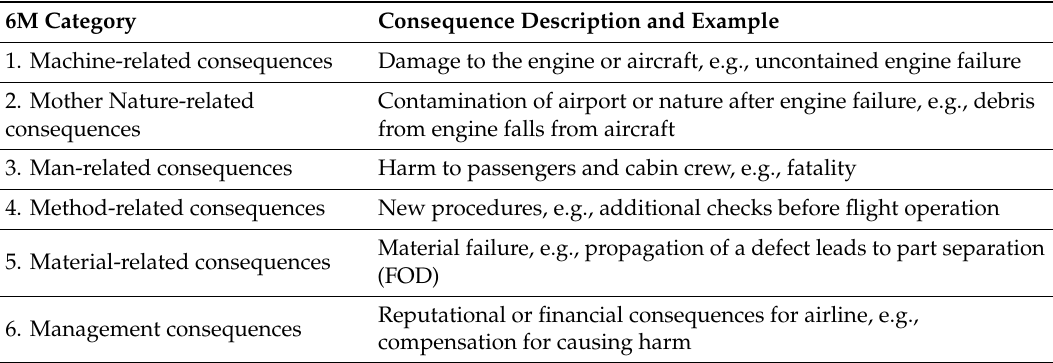
Table 4. The 6M categories for subsequent consequences for the airline with description and example.